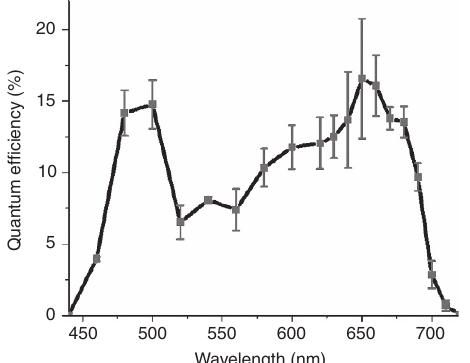
Figure 5 | Quantum efficiency. The quantum efficiency, that is, the photo induced electrons per photons, measured at various wavelengths from 440 to 720nm with a spectral bandwidth of 10nm. Measurements were taken with different samples of thylakoids (0.1mgChl) for each wavelength. The photocurrent was measured at a potential of 0.5V Ag/AgCl . The values error bars represent the s.d. over three